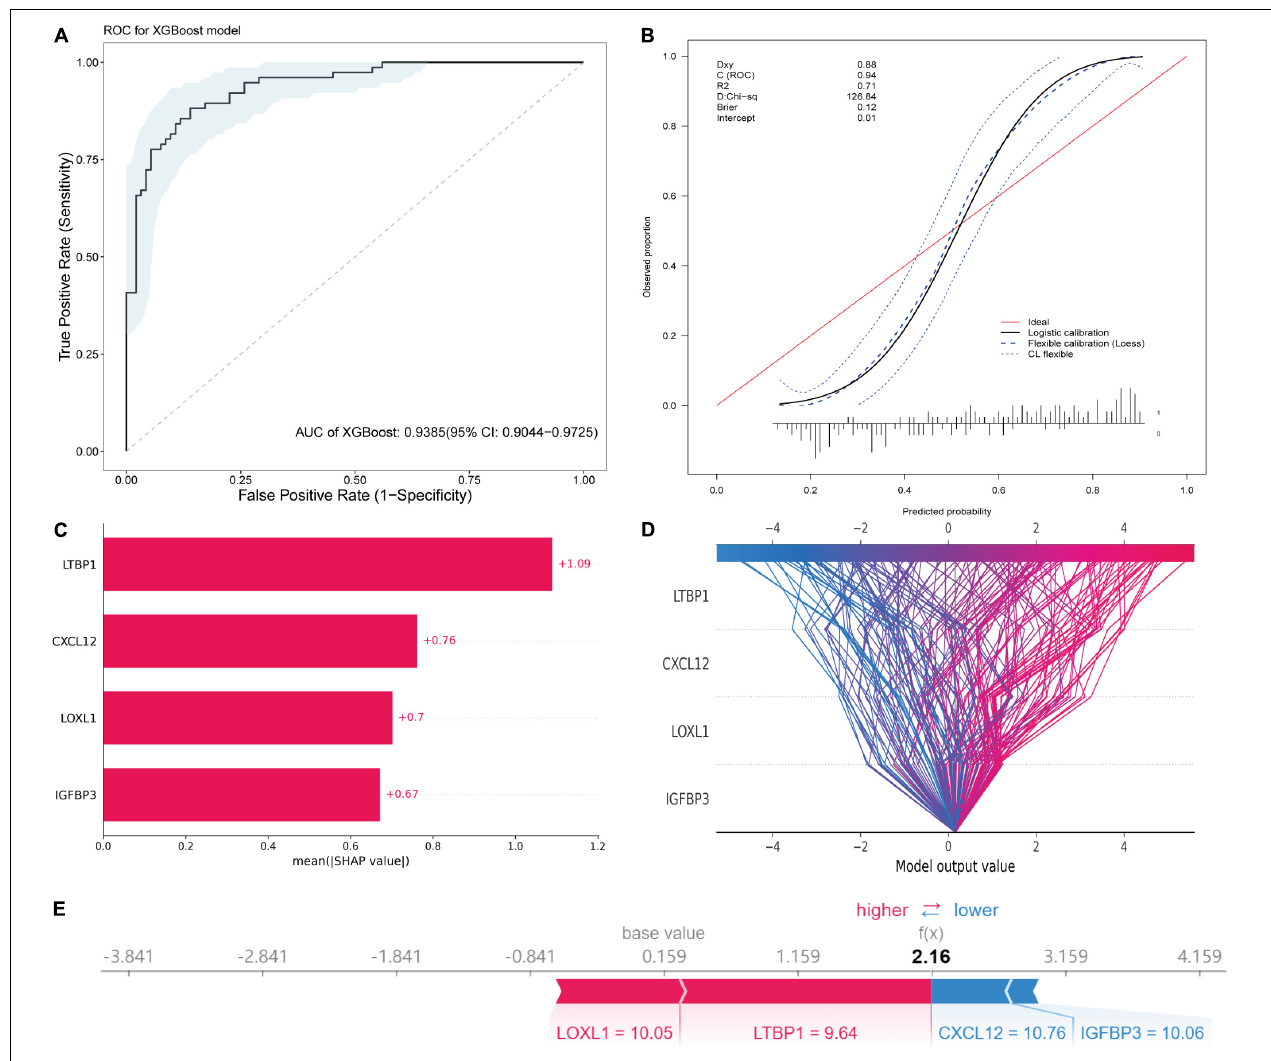
FIGURE 10 | Diagnostic model construction, validation and visualization. (A) ROC plot of XGBoost algorithm-based diagnostic model. (B) The calibration curve of the diagnostic model. (C) Importance plot of the diagnostic model. (D) The decision plot showing global interpretability of the model. (E) The force plot showing example explanation on an individual